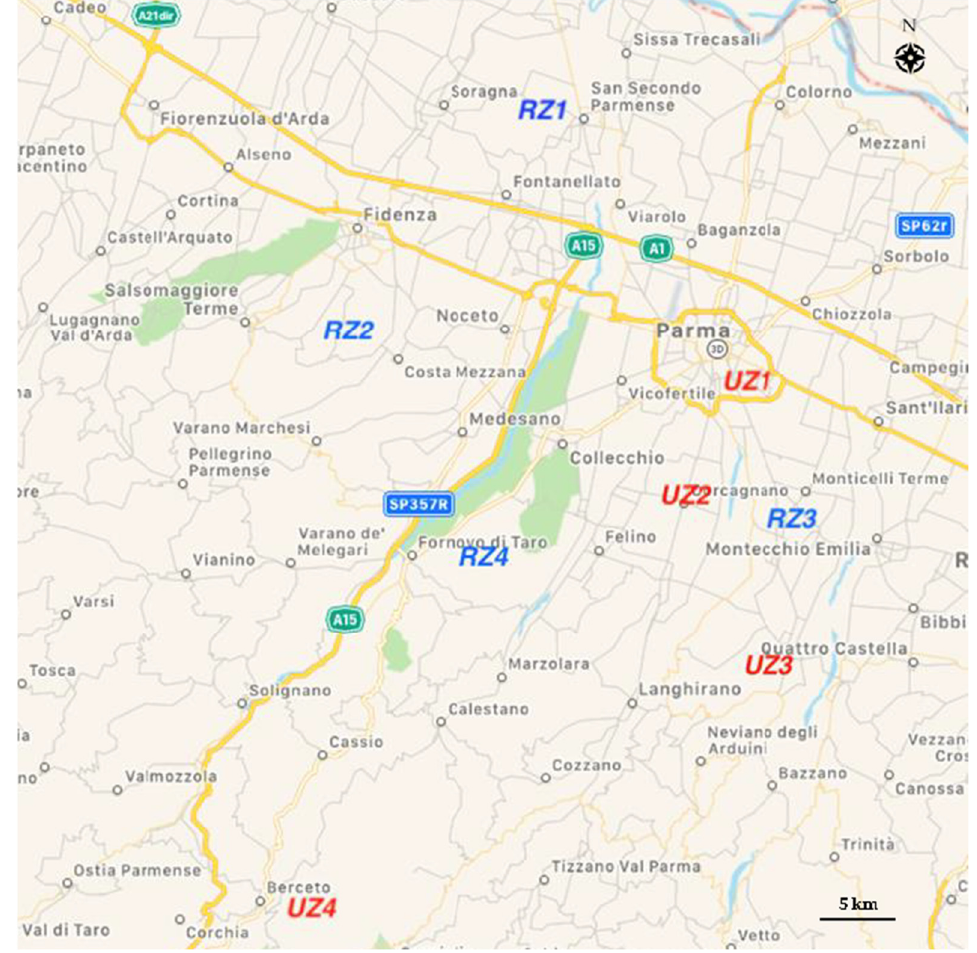
Figure 1. Cartographic image of the Eurasian magpie sampling zones, in the province of Parma (Italy). UZ (1–4) are sampling zones within 1 km from urban areas; RZ (1–4) are sampling zones farther than 5 km from urban areas.